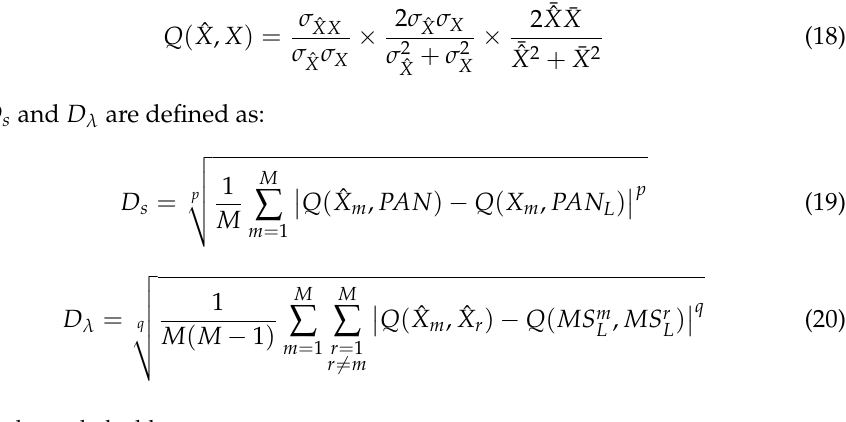
Table 4. Formula symbol